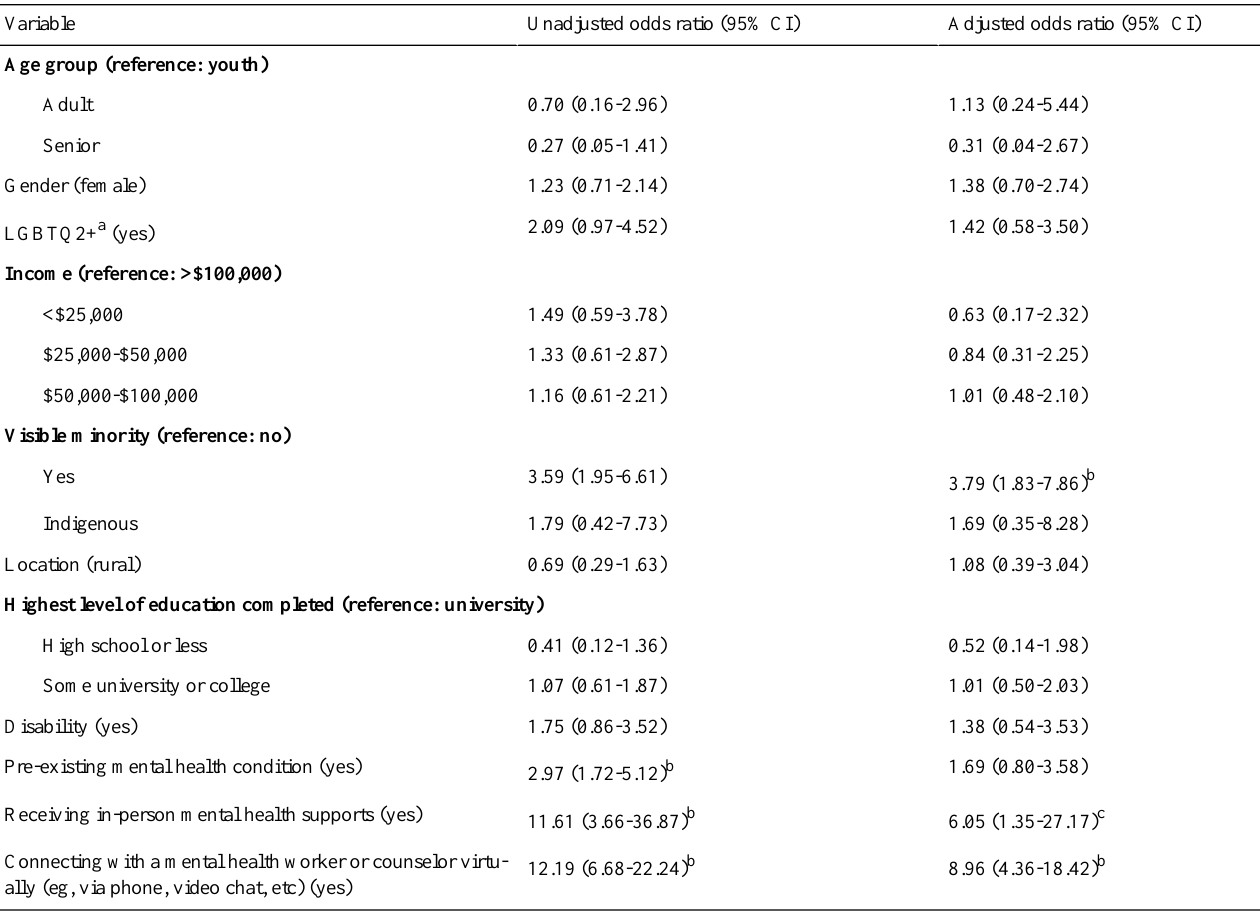
Table 3. Results of univariate and fully adjusted multivariate logistic regression models examining the association between use of asynchronous virtual mental health resources and sociodemographic characteristics among participants who reported adverse mental health impacts related to the COVID-19 pandemic